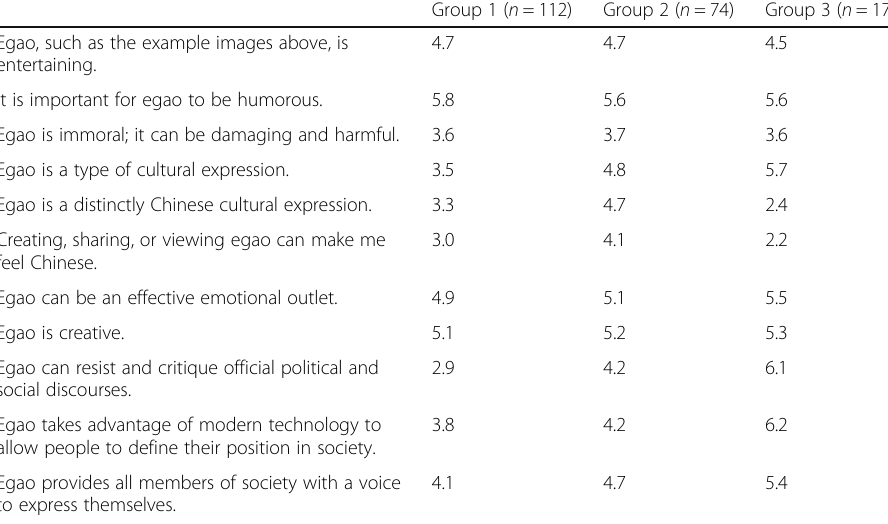
Group 1 ( n = 112) Group 2 ( n = 74) Group 3 ( n = 17)